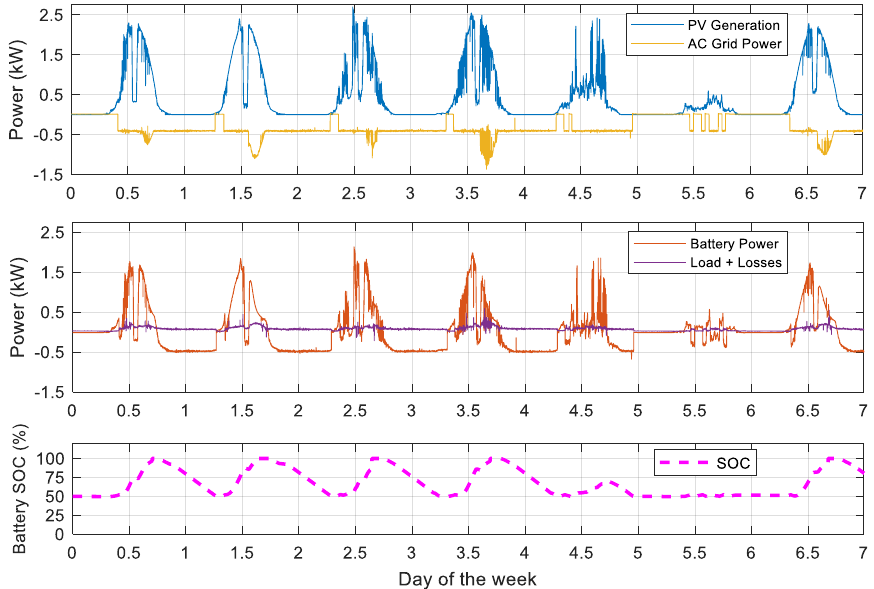
Figure 15. Measurement over one week in May: ( Top ) the generated PV power and power fed to the grid. ( Middle ) battery charging power (positive), discharging power (negative), the load, and power losses. ( Bottom ) SOC of battery.